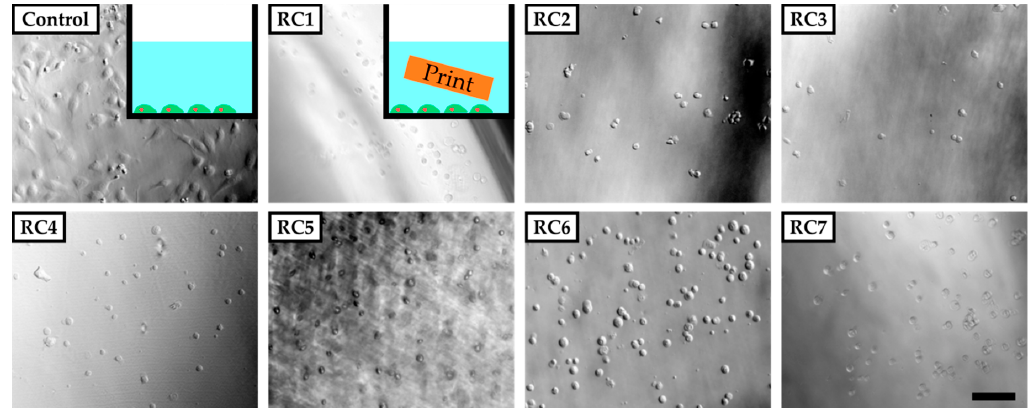
Figure 2. Phase-contrast images of human umbilical vein endothelial cells (HUVECs) five hours after seeding in poly(styrene) (PS) culture vessels coated with fibronectin. The cells adhere and spread on the surface of the vessel in the absence of any 3D-printed parts (inset top left corner). In the presence of 3D-printed test objects made from resins RC1 to RC7 added to the vessel, cells do not adhere to the surface of the PS vessel but remain in solution with a spherical shape. The scale bar denotes 200 µm.